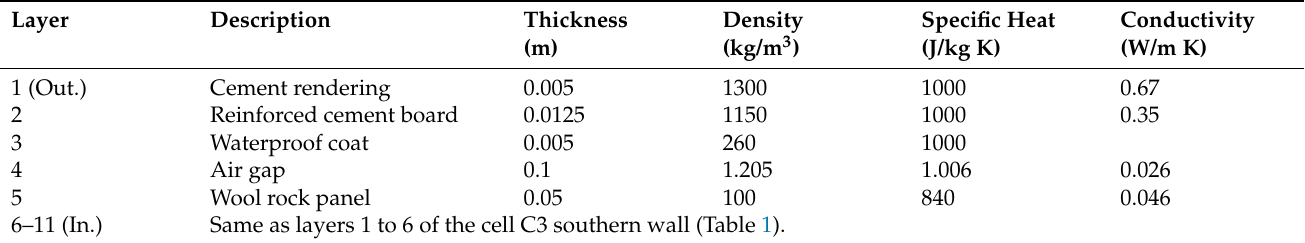
Table 3. Thermophysical properties of the materials used in the